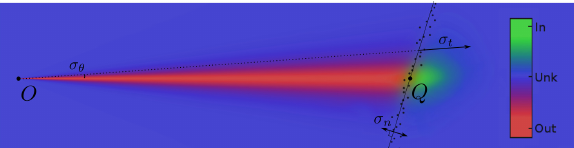
Figure 3: Mass function in R 2 for a beam defined by the sensor center O and the 3D point Q . The parameters are: the incertitude on the angle σ θ , on the data σ n and the thickness of the scene σ t .